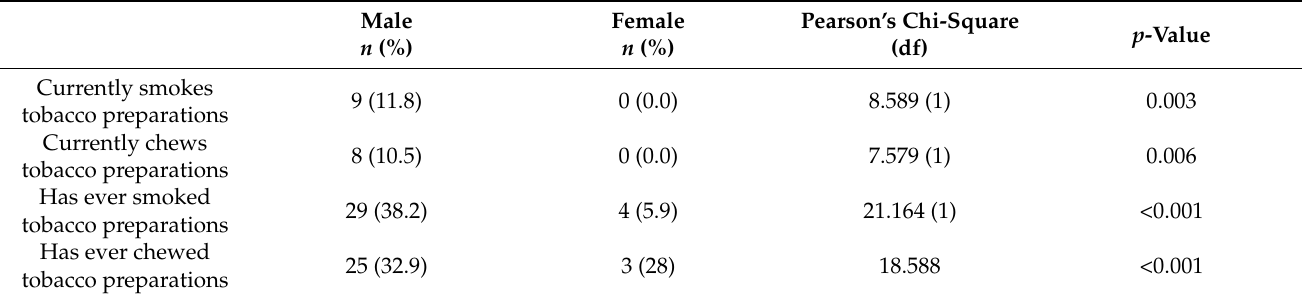
Table 6. Associations between gender and use of tobacco